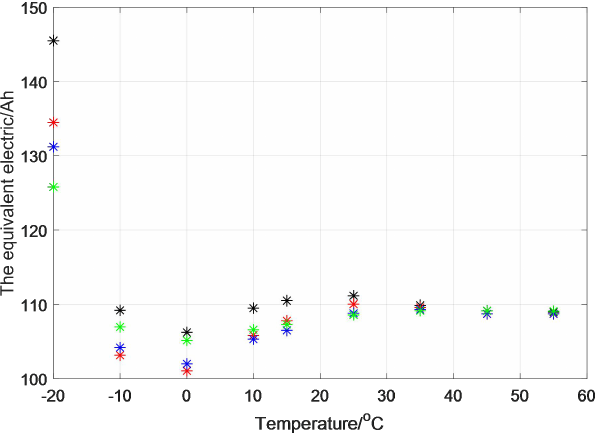
Figure 7. The equivalent electric discharged during the discharging process in various